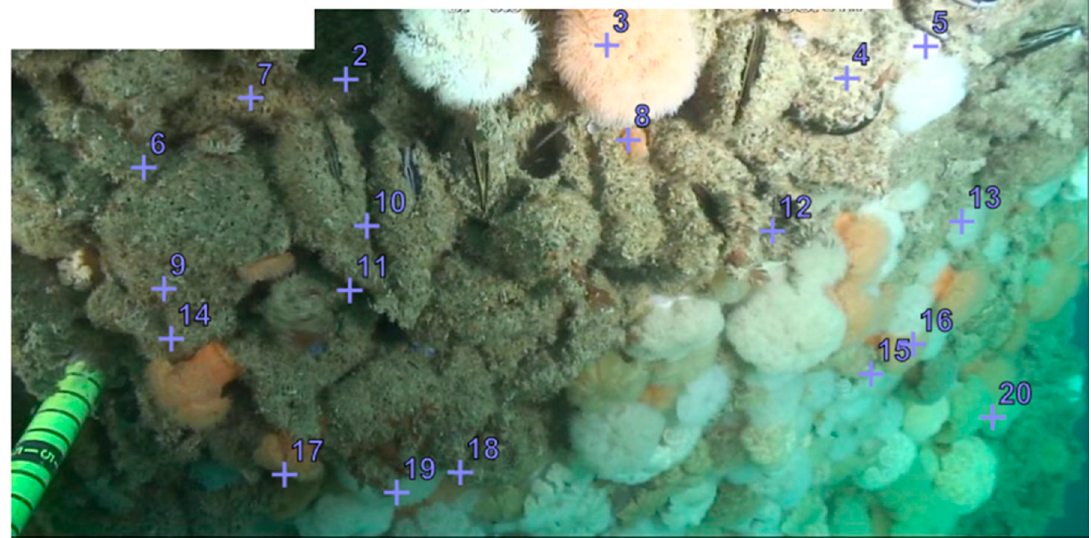
Figure 2. Screen grab representing training annotation layout 20 simple random points, annotation area: X: 10–95%/Y: 10–95%; and scale bar protrusion used for determining distance from ROV to surface. Platform and location identifies have been removed from all images. Purple crosses and numbers indicate annotation points.